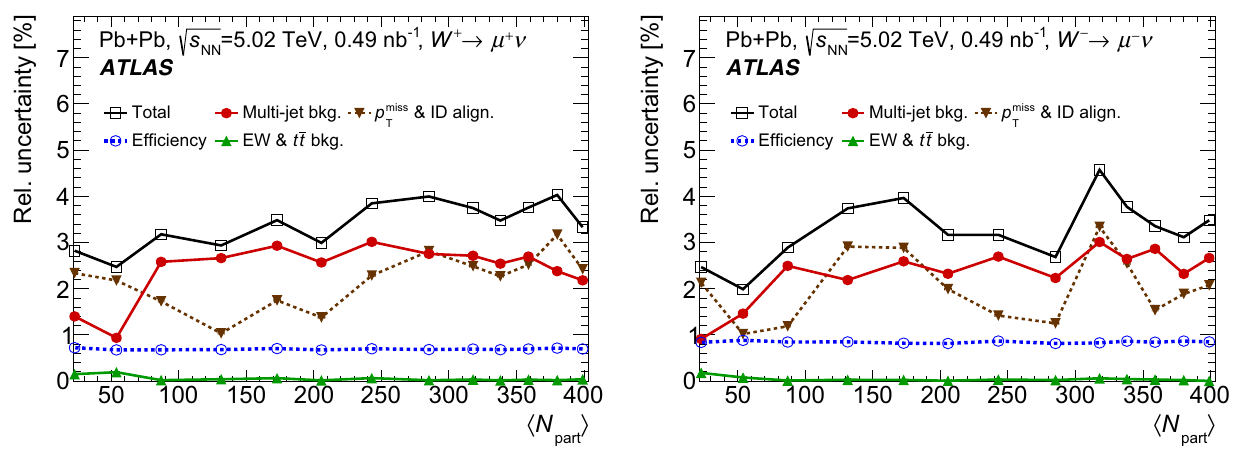
Fig. 6 Relative systematic uncertainties of W + (left) and W − (right) boson production yields measured in the muon decay channel evaluated as a function of (cid:4) N part (cid:5) . The total systematic uncertainty is represented by open squares, while other markers represent contributions from indi- vidual sources of uncertainty. The uncertainties related to muon effi-